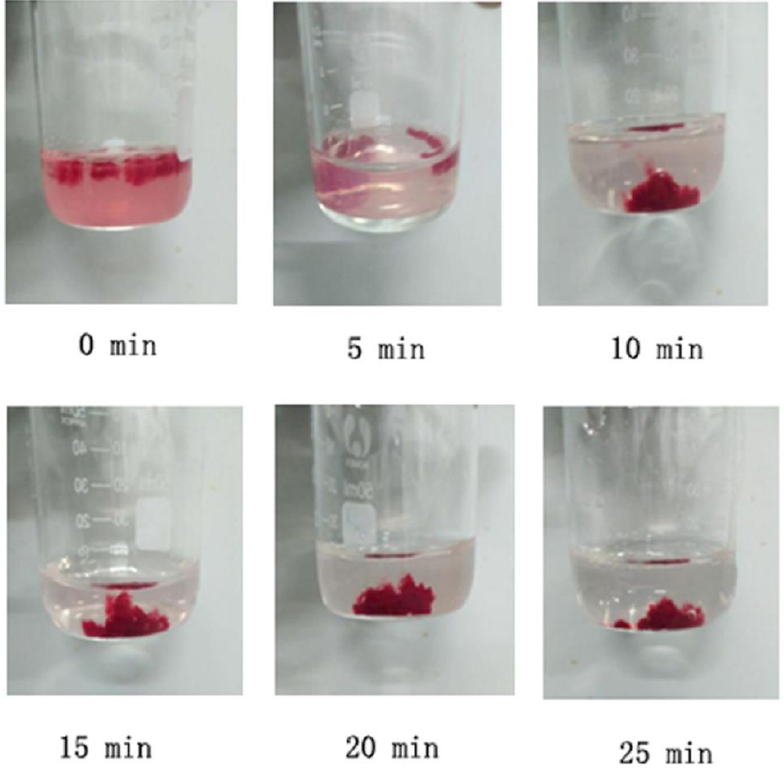
Figure 7. Dynamic coagulation process of chitosan (CS-D3).